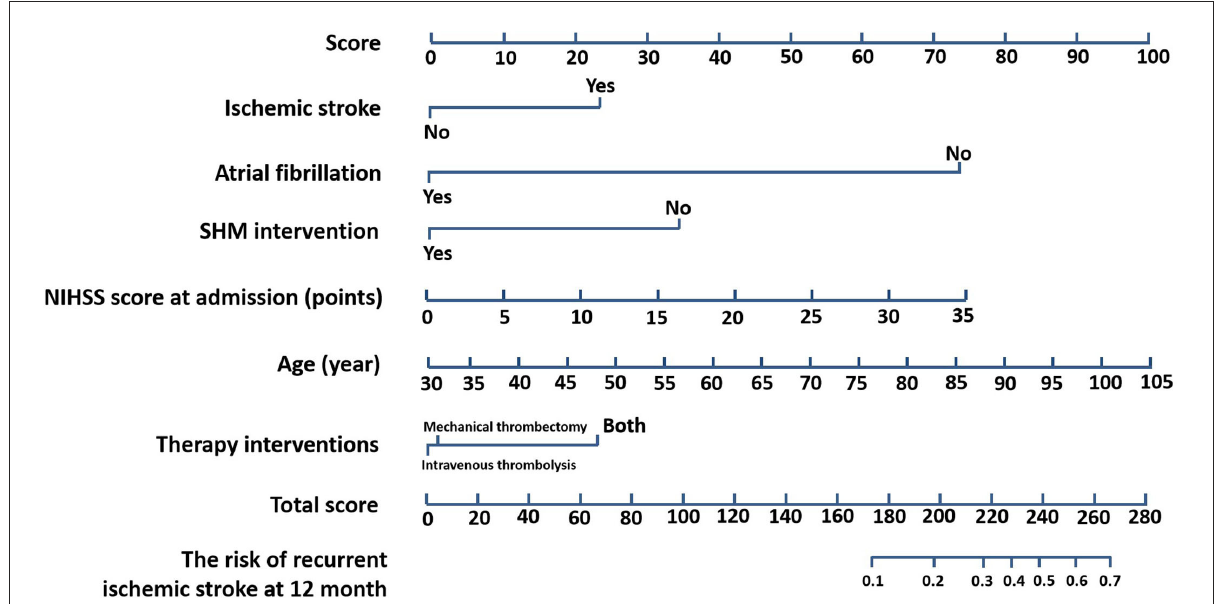
FIGURE3 Nomogram for prognostic prediction. Nomogram (SHM intervention, age, NIHSS score at admission, atrial fibrillation, ischemic stroke, therapy interventions) for predicting the risk of recurrent ischemic stroke at 12 months. The importance of each variable was ranked according to the standard deviation along nomogram scales. SHM, stroke health manager; NIHSS, National Institutes of Health Stroke